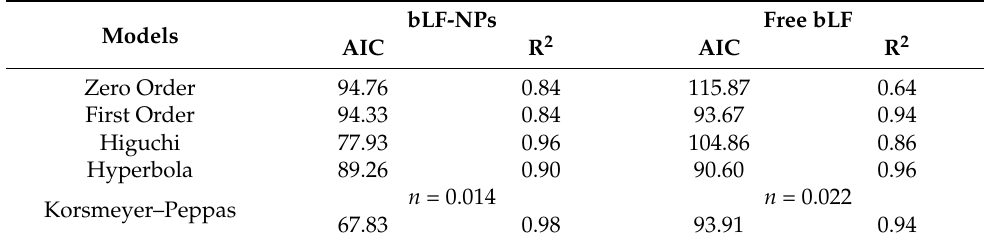
Table 3. Parameters for kinetic models of bLF-NPs and free bLF solution.